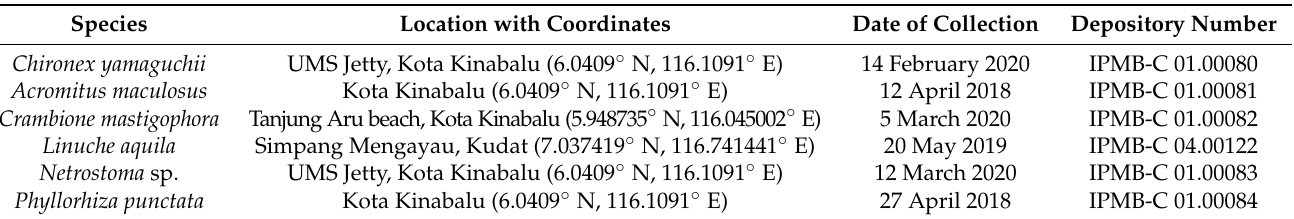
Table 1. Species and locations of jellyfish collected in the Sabah waters with the date and depository number.